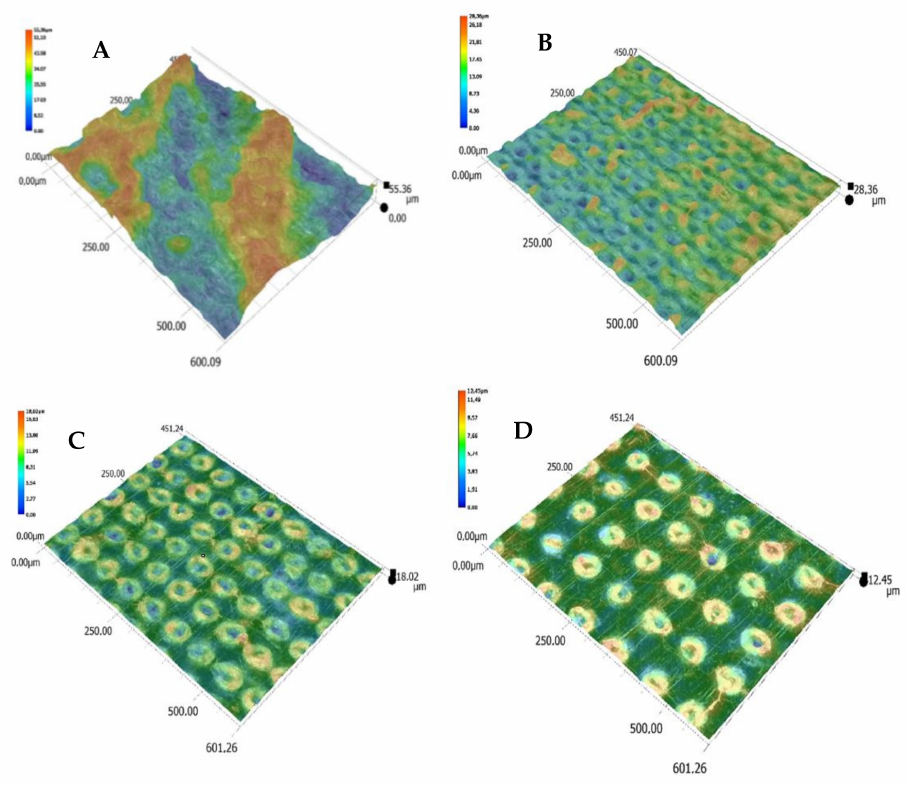
Figure 15. Change in the molding surface (S5) topography as a result of the laser beam action with various parameters: ( A ) 450 mm/s, 0.03 mm; ( B ) 750 mm/s, 0.05 mm; ( C ) 1050 mm/s, 0.07 mm; ( D ) 1350 mm/s, 0.09; magnification: 500 × ; dimensions of investigated images: 450 µ m × 600 µ m (Keyence